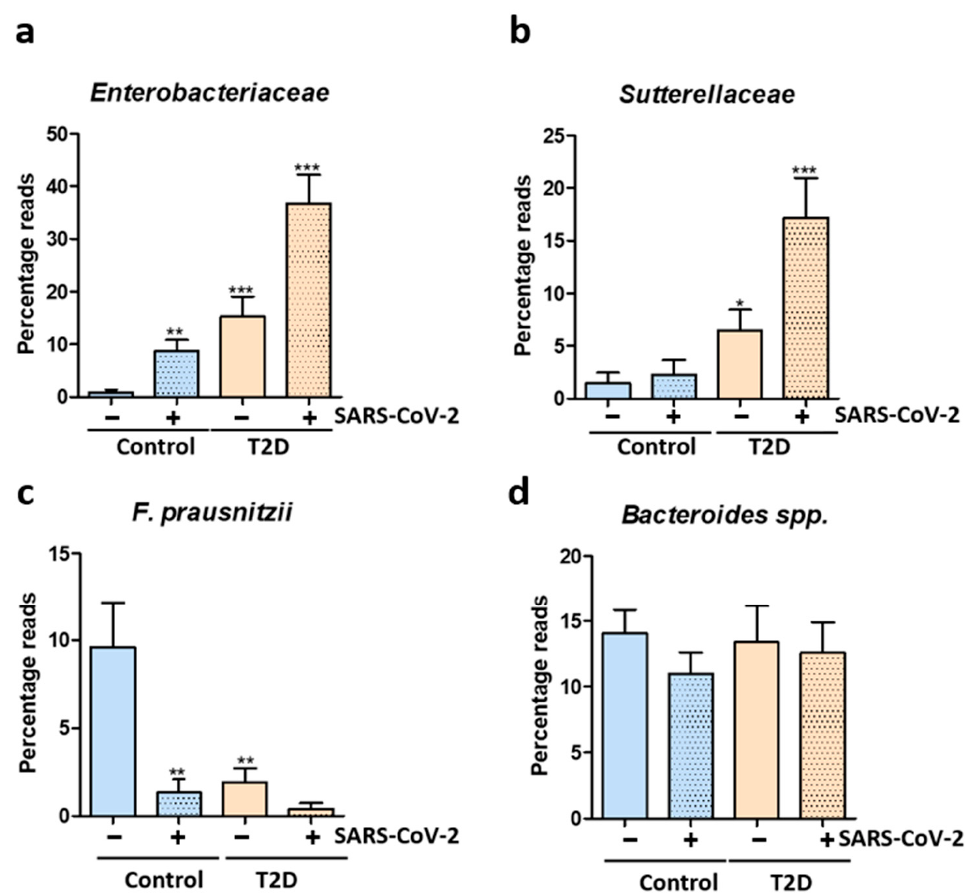
Figure 3. Microbiome alterations after SARS-CoV-2 infection in T2D patients and healthy controls. ( a ) Relative abundance of Enterobacteriaceae expressed as percentage reads using next generation sequencing in uninfected and infected T2D patients and healthy controls; ( b ) Relative abundance of Sutterellaceae expressed as percentage reads using next generation sequencing in uninfected and in- fected T2D patients and healthy controls; ( c ) Relative abundance of F. prausnitzii expressed as per- centage reads using next generation sequencing in uninfected and infected T2D patients and healthy controls; ( d ) Relative abundance of Bacteroides spp. expressed as percentage reads using next gener- ation sequencing in uninfected and infected T2D patients and healthy controls. Statistical analysis was performed by 1-way ANOVA post hoc Bonferroni test. The statistical significance levels: *, p < 0.05; **, p < 0.01; ***, p < 0.001. We also explored the mycobiome changes before and after SARS-CoV-2 infection. We show that T2D patients, both before and after SARS-CoV-2 infection have a mycobi- ome enriched in fungi such as Candida spp., Aspergillus spp., Debaryomyces spp. and Peni- cillium spp. (Figure 4a–d). Importantly, SARS-CoV-2 infection induced an enrichment of the Candida spp., Aspergillus spp., Debaryomyces spp. and Penicillium spp. fungal popula- tions in the gut of healthy controls (Figure 4a–d). We next correlated the main taxa identified with the patient clinical parameters in- cluding viral load, ROS and NOS levels, NADPH oxidase expression, IL-8, IL-1 β , IL-17, CRP, and butyrate (Figure 5). The Spearman correlation analysis revealed significant correlations between the viral load and Enterobacteriaceae , Bacteroidaceae , Rickenellaceae (**** p < 0.0001), Porphyromona- daceae (**** p < 0.0001), Parasutterella (**** p < 0.0001) and Alistipes abundance. Negative correlations between viral RNA levels and the microbiome were identified for Ruminococ- caceae (**** p < 0.0001), Faecalibacterium (**** p < 0.0001), Lachnospiraceae (**** p < 0.0001), Bifidobacteriaceae and Eubacteriaceae (**** p < 0.0001).